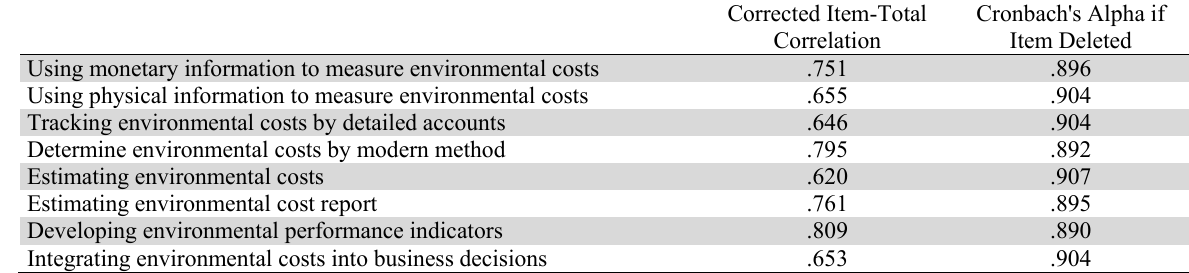
Corrected Item-Total Correlation